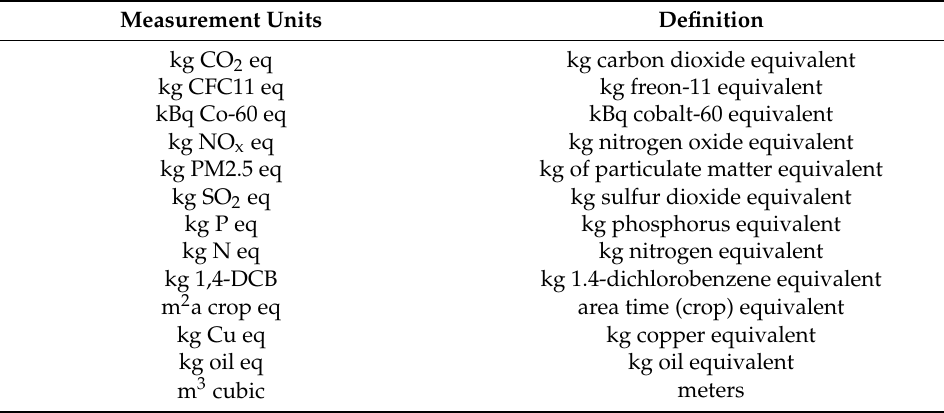
Table 6. Impact category units of